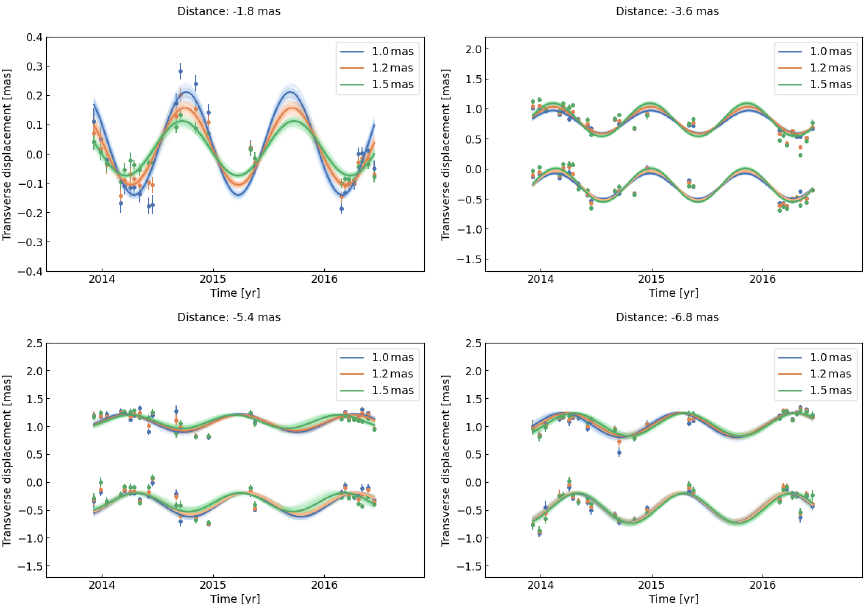
Figure A2. Transverse oscillations of the M87 jet, obtained at distances of 1.8, 3.6, 5.4, and 6.8 mas by applying different sizes of restoring beams. The blue, orange, and green dots represent the transverse displacement of the ridge lines obtained by applying circular restoring beams with a radius of 1.0, 1.2, and 1.5 mas, respectively, and the solid lines are their sinusoidal fitting results. At all distances, the oscillation period is almost unchanged with respect to the beam size, while the amplitude is slightly